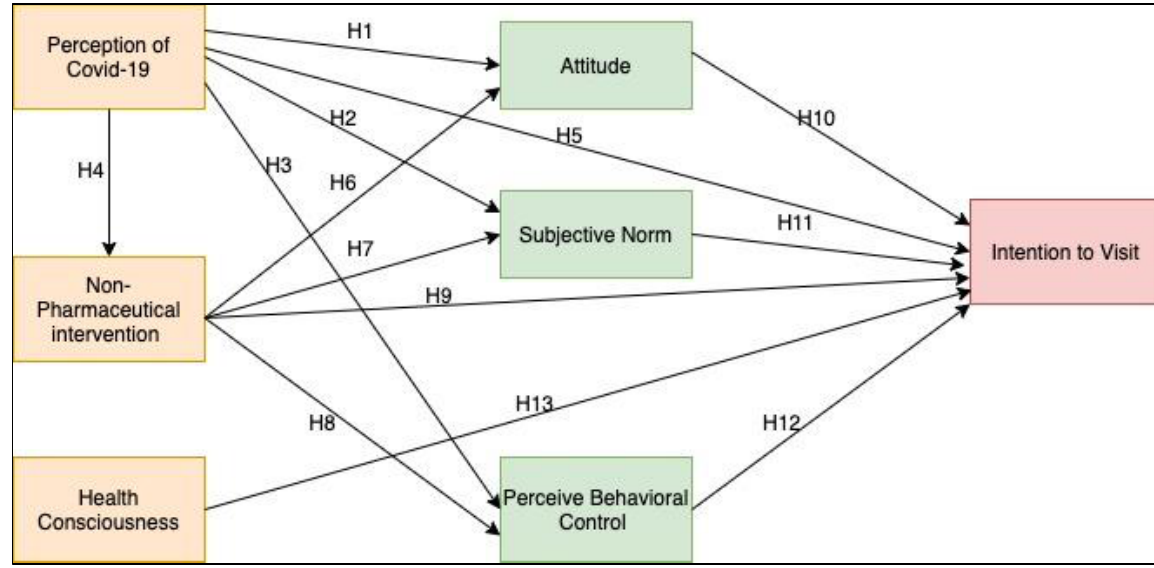
Figure 1. Research